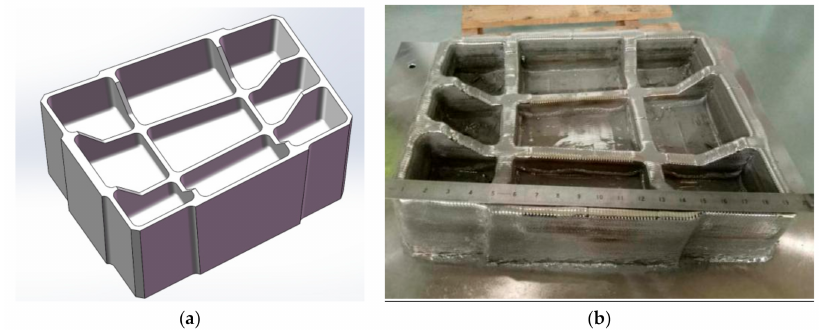
Figure 9. Hanging frame model and physical diagram. ( a ) Model diagram; ( b ) physical